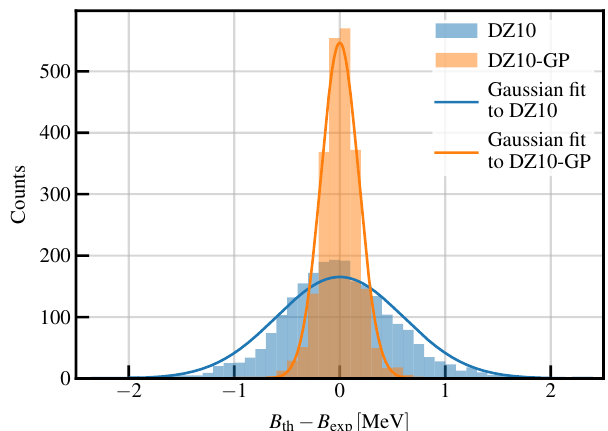
Figure 5. Distributions of the residuals for the DZ10 and DZ10-GP models for measured masses. Gaussian fits to the residuals are also shown, with the mean fixed to 0 and the standard deviation fixed to that of the residuals. See text for details.